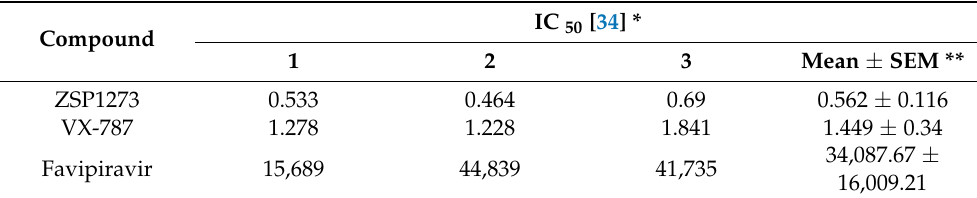
Table A1. Inhibitory effects of ZSP1273 on influenza virus